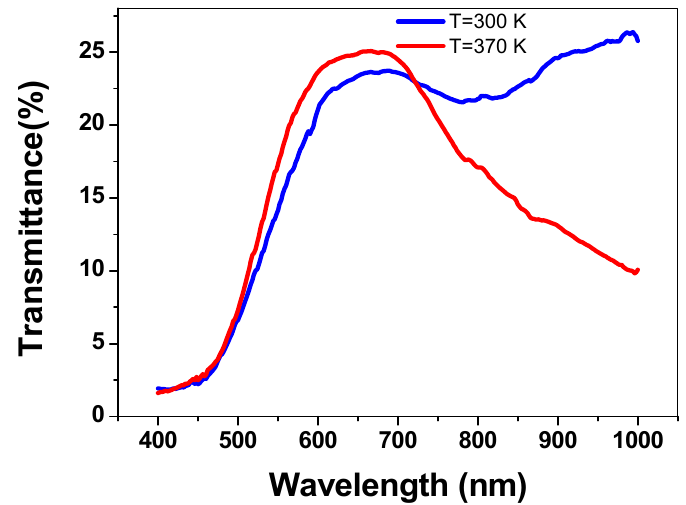
Figure 2. Optical transmittance of a VO 2 thin film on glass below (300 K) and above (370 K) T SMT upon wavelength variation in the range 400–1000 nm.